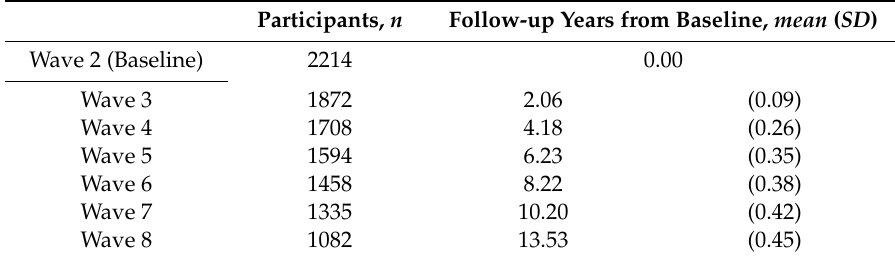
Table 1. Information on follow-up